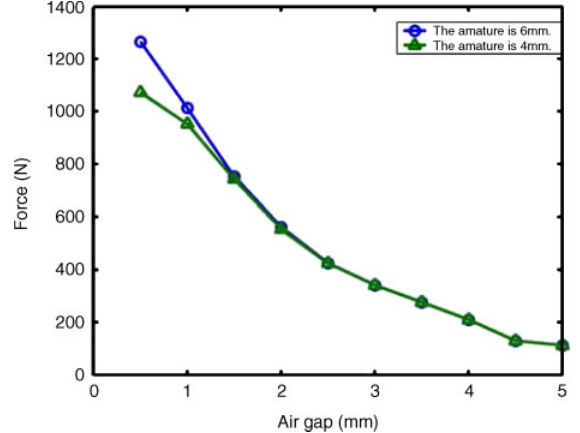
Figure 7 Influence of thickness of the armature.